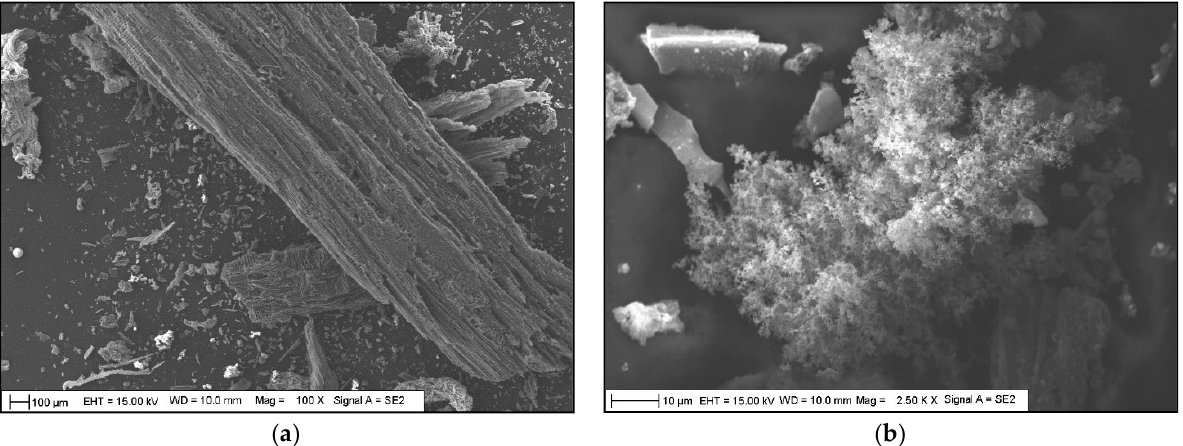
Figure 15. SEM images of fly ash from KAJOT gasifier: ( a ) large block containing mostly carbon; ( b ) amorphous carbon.